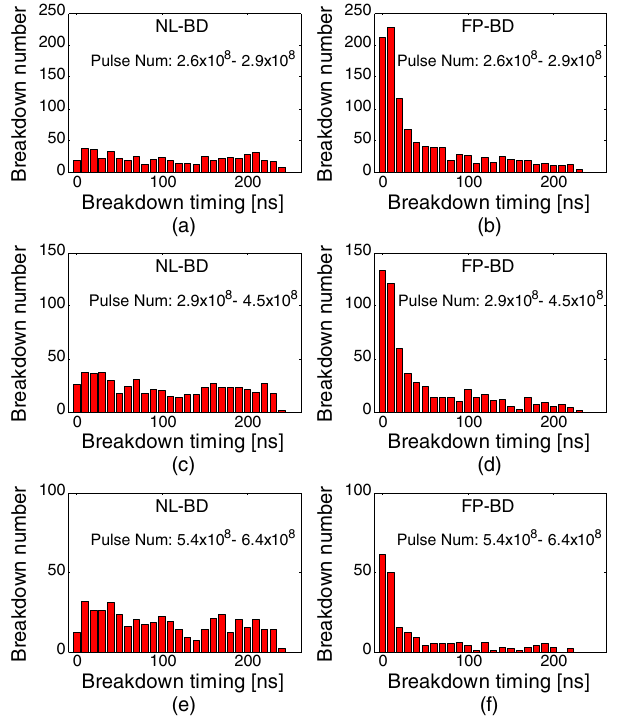
FIG. 11. Breakdown timing distribution in different processing stages of the 252 ns